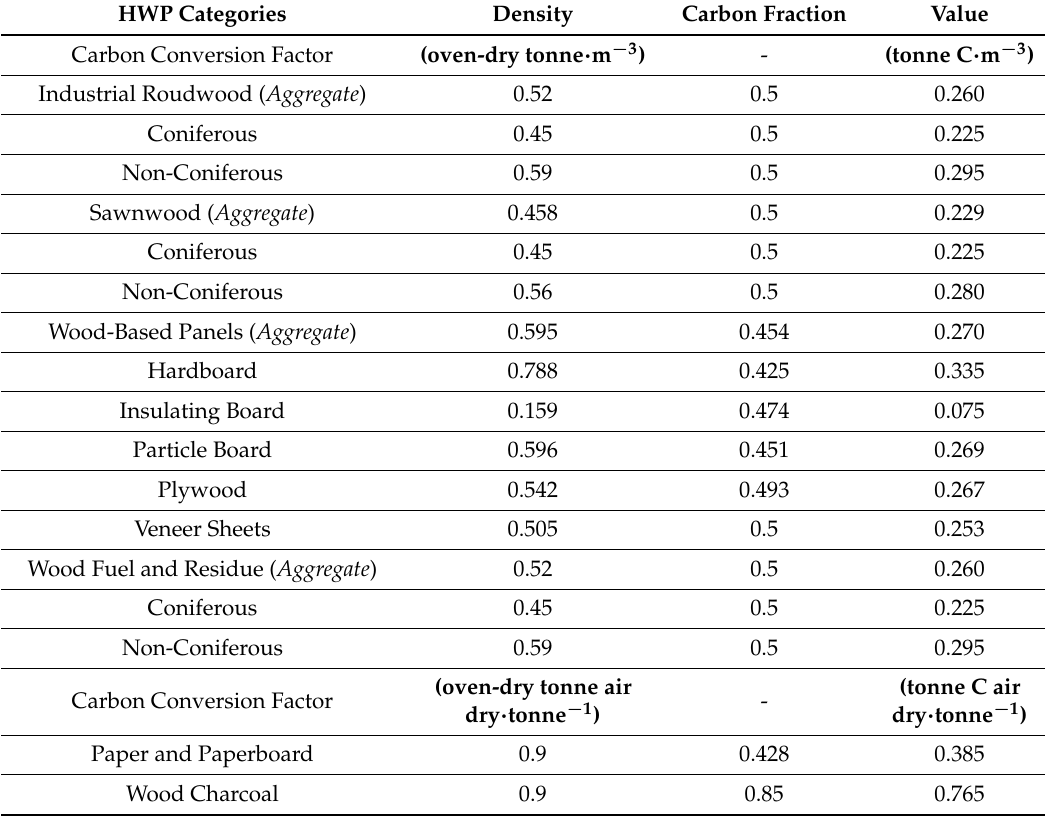
Table A1. Conversion factors for the HWP categories and the subcategories.